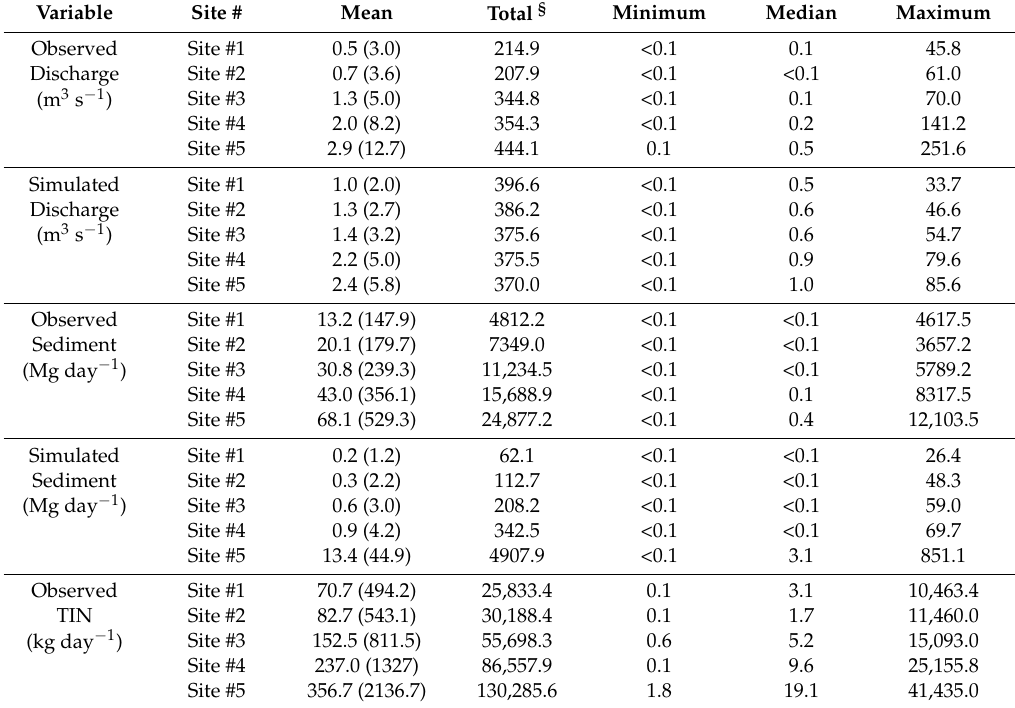
Table 3. Descriptive daily statistics showing observed developed and simulated pre-development discharge, sediment, total inorganic nitrogen (TIN) and total phosphorus (TP) at five gauging sites on Hinkson Creek, Missouri, USA. Standard deviations are shown in